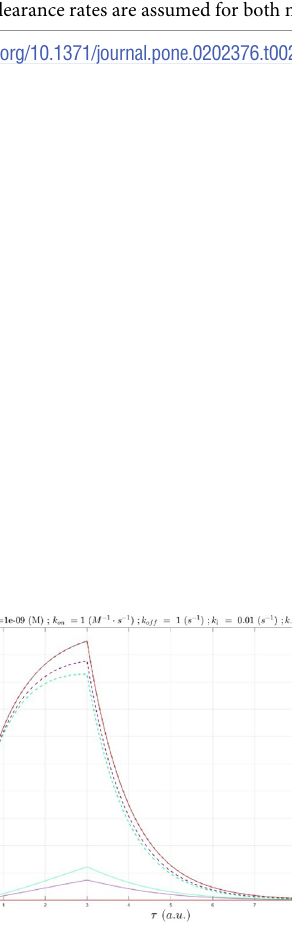
= k = 1x10 -2 s -1 ), and the i − i